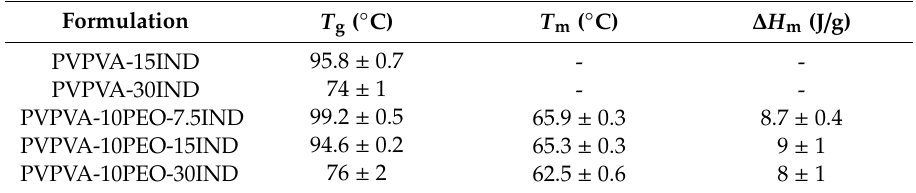
Figure 4. DSC thermograms of binary and ternary injection moulded solid dispersions of PVPVA-IND and PEO. Table 4. Glass transition temperature of binary and ternary injection moulded solid dispersions of PVPVA-IND and PEO.